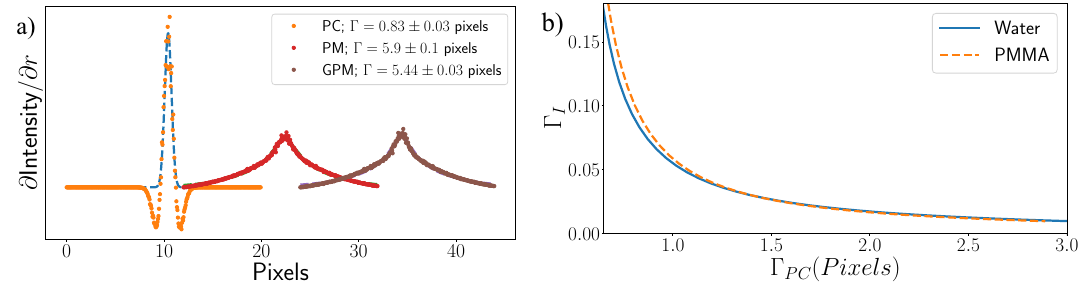
Figure 2. ( a ) Azimuthally averaged imaging system Line Spread Functions (LSF)s of the circular phantom image showing the effect of phase retrieval on spatial resolution from the phase contrast (PC) and phase retrieved images using the PM and GPM algorithms for a sample composed of water. Underlying dashed curves represent Pearson VII fits used to measure the LSF width. The phase contrast PSF was rescaled vertically by a factor of 8 for plotting. ( b ) Plots the percentage improvement in resolution, according to Eq. (14) of the GPM, plotted against the initial resolution of the simulated